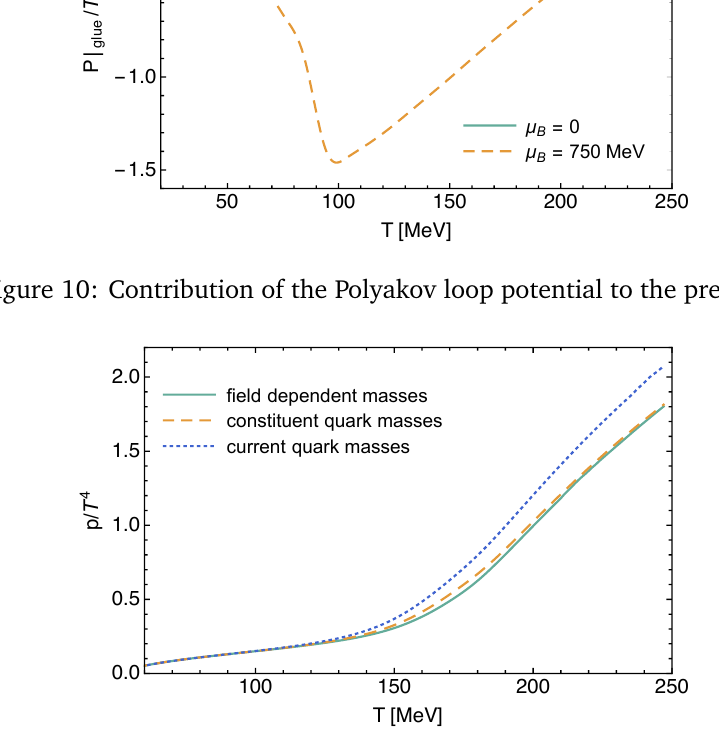
= 3.6 MeV and l = 300 MeV and m = 430 l s